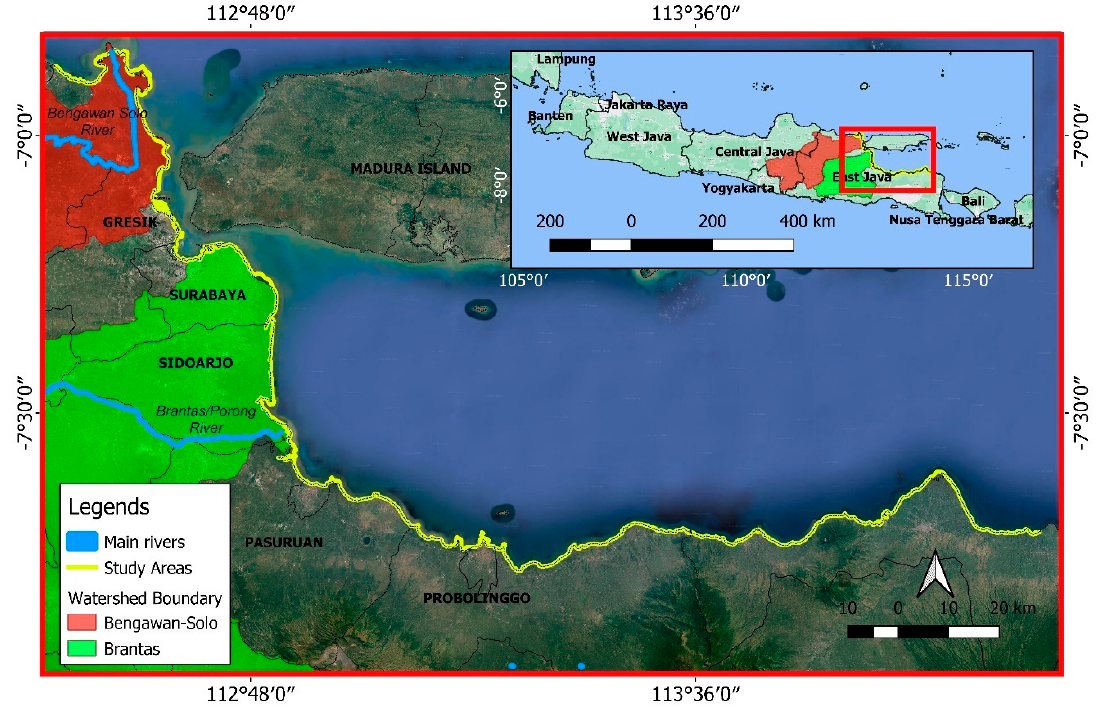
Figure 1. The study area (yellow line), comprising the coastline of the main island of Java Island, Indonesia.